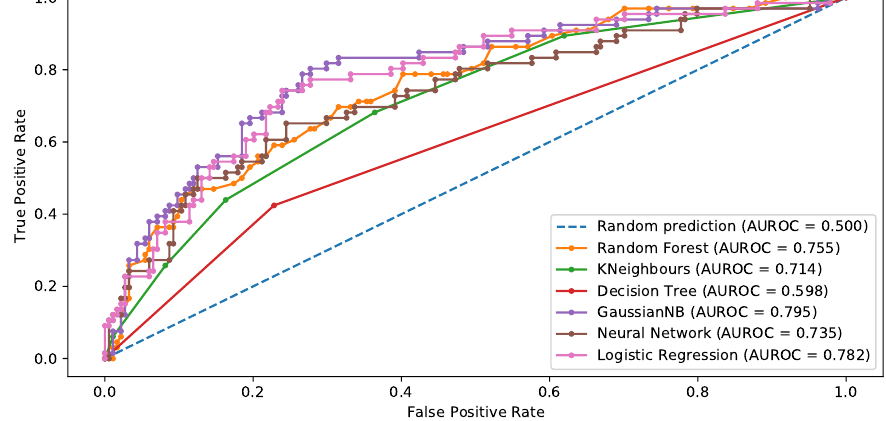
Figure 2. Imbalanced data.